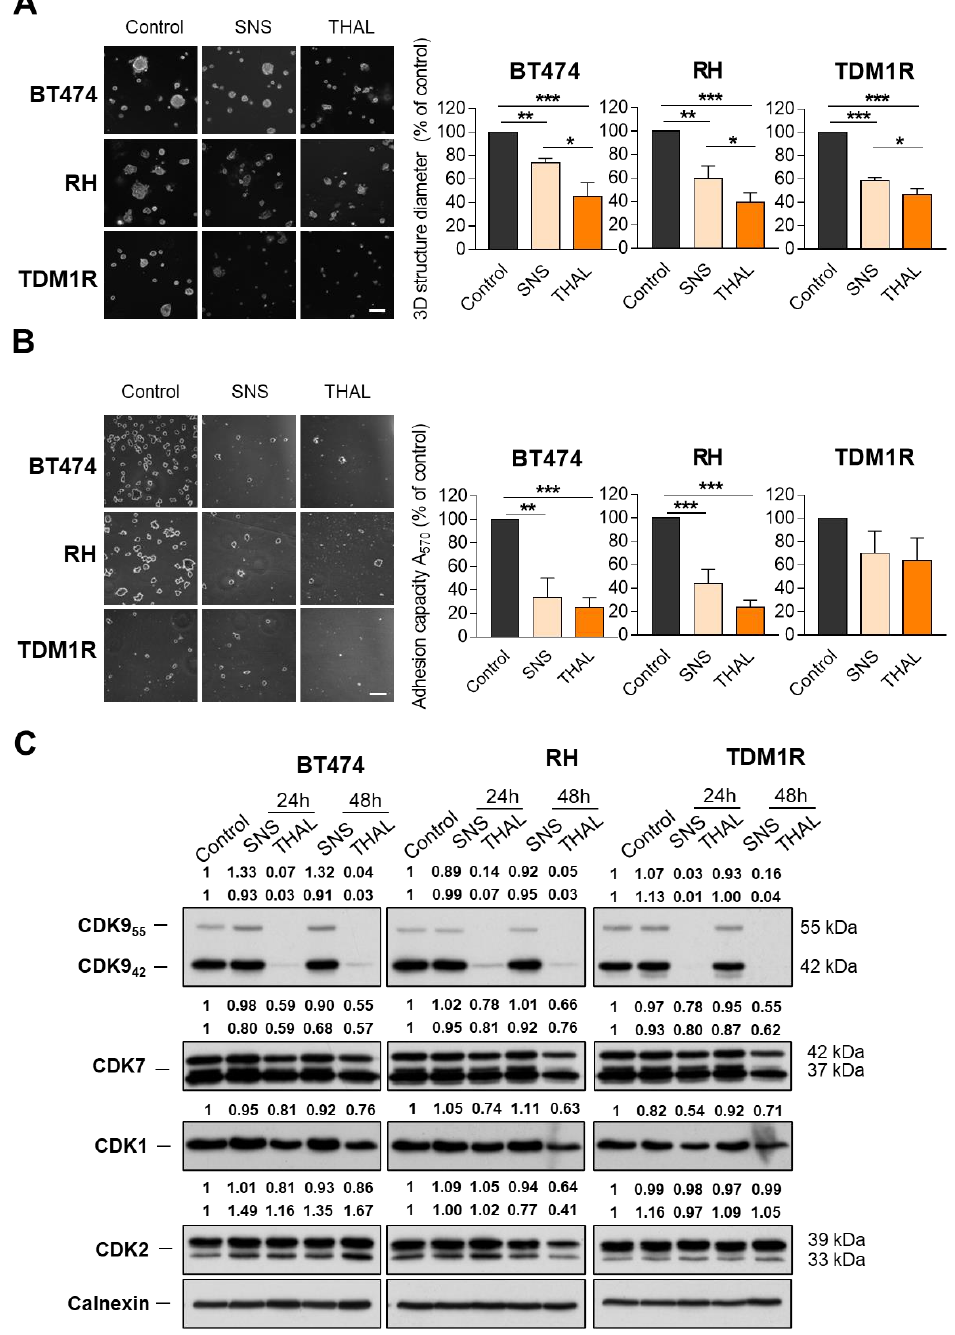
Figure 3. Antitumoral effect of SNS-032 and THAL-SNS-032 in 3D-matrix and adhesion assays in breast cancer lines and CDKs protein level evaluation after treatments. SNS-032 or THAL-SNS-032 (100 nM) was applied for 72 h to BT474, RH, and TDM1R cells seeded in a Matrigel matrix. Results presented refer to control cells. Scale bar = 100 µ m ( A ). Cell adhesion to fibronectin substrate after 24 h of exposure to SNS-032 or THAL-SNS-032 (100 nM) ( B ). Expression levels of CDK9, CDK7, CDK1, and CDK2 in BT474, RH, and TDM1R cells treated with SNS-032 and THAL-SNS-032 at the times indicated at 50 nM. Scale bar = 100 µ m ( C ). * p < 0.05; ** p < 0.01; *** p <